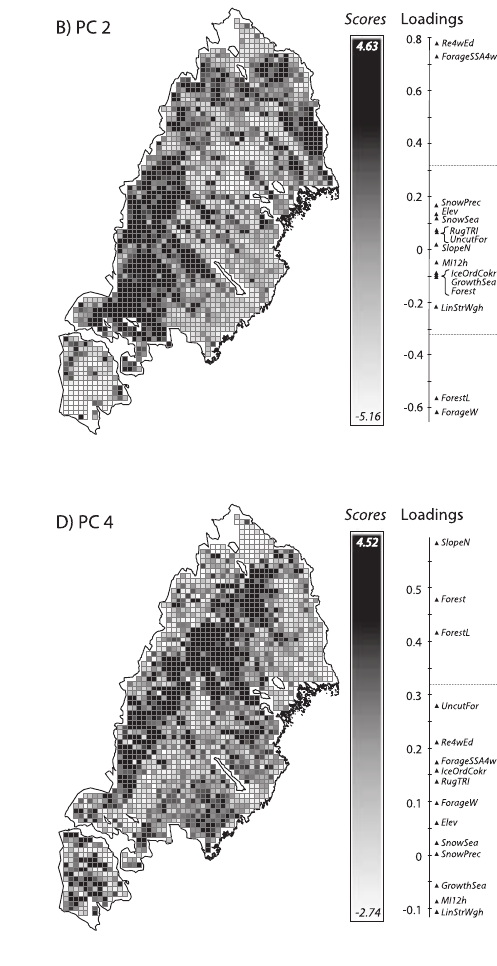
Fig. 6. Geographical distribution of PC scores of 1958 squares based on the 15 retained variables in the first five principal components. Maximum and minimum score values of the PCs are in italics inside the legends. The loadings of the 15 vari- ables in each PC are shown on the vertical axis. The grey dotted lines represent the factor loading value (±0.32), which accounts for 10% of the variance in the component (e.g., McGarigal et al ., 2000). Loadings with absolute values exceeding 0.13 are considered statistically